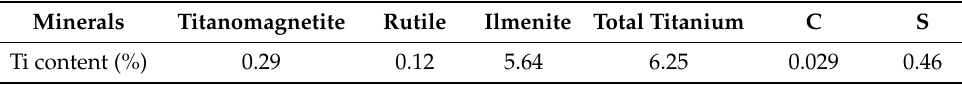
Table 2. Phase analysis results of titanium mineral samples.